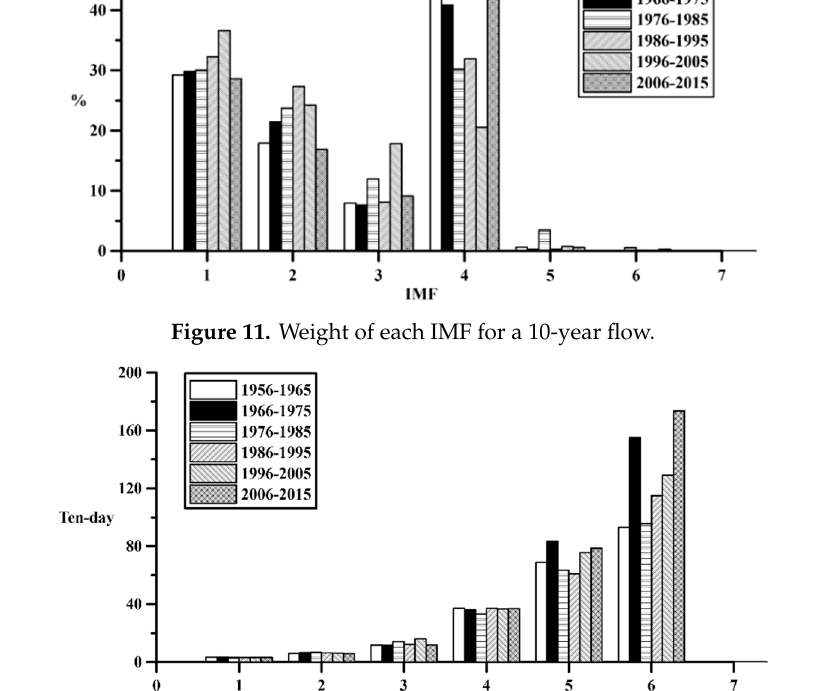
Figure 12. Average period of each IMF for a 10-year flow. Table 4. Results of decadal data by EMD with energy and period.